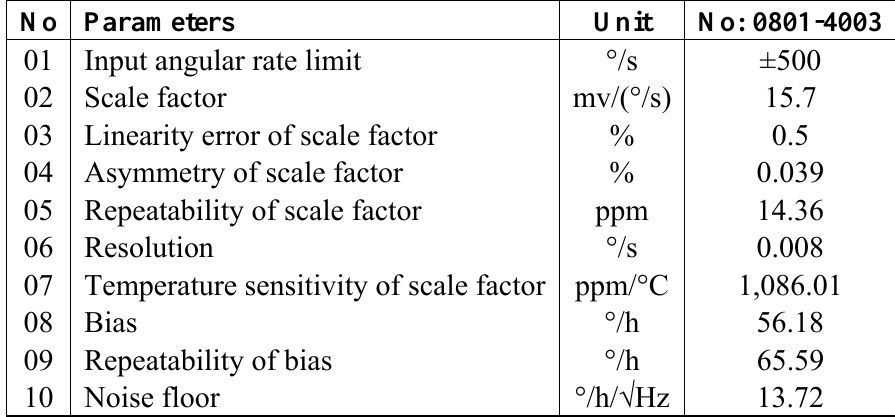
Table 1. The main performance specifications of the